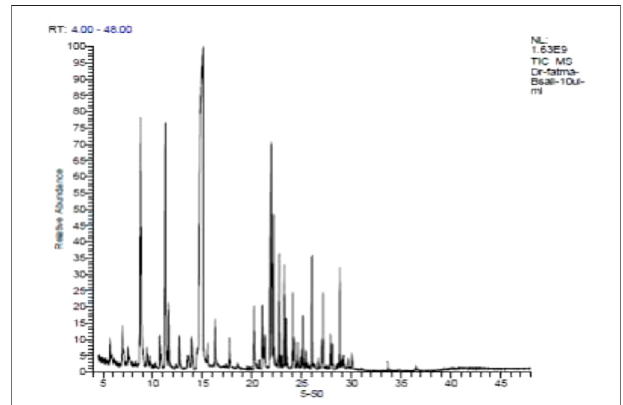
FIGURE 1 | GC-MS chromatogram of basil essential oil.